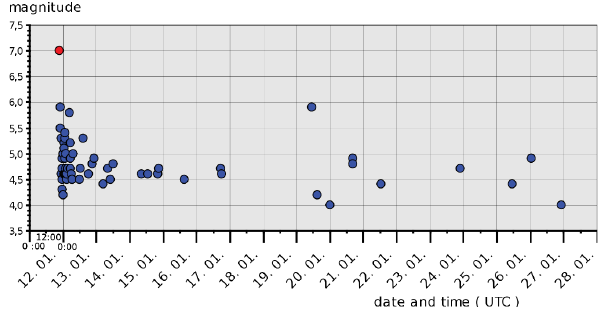
Figure 1a. Showing location of epicenter of Haiti earthquake event of 12 January 2010. (Source - http://www.bgs.ac.uk/research/highlights/haitiEarthquakeJan2010.html)